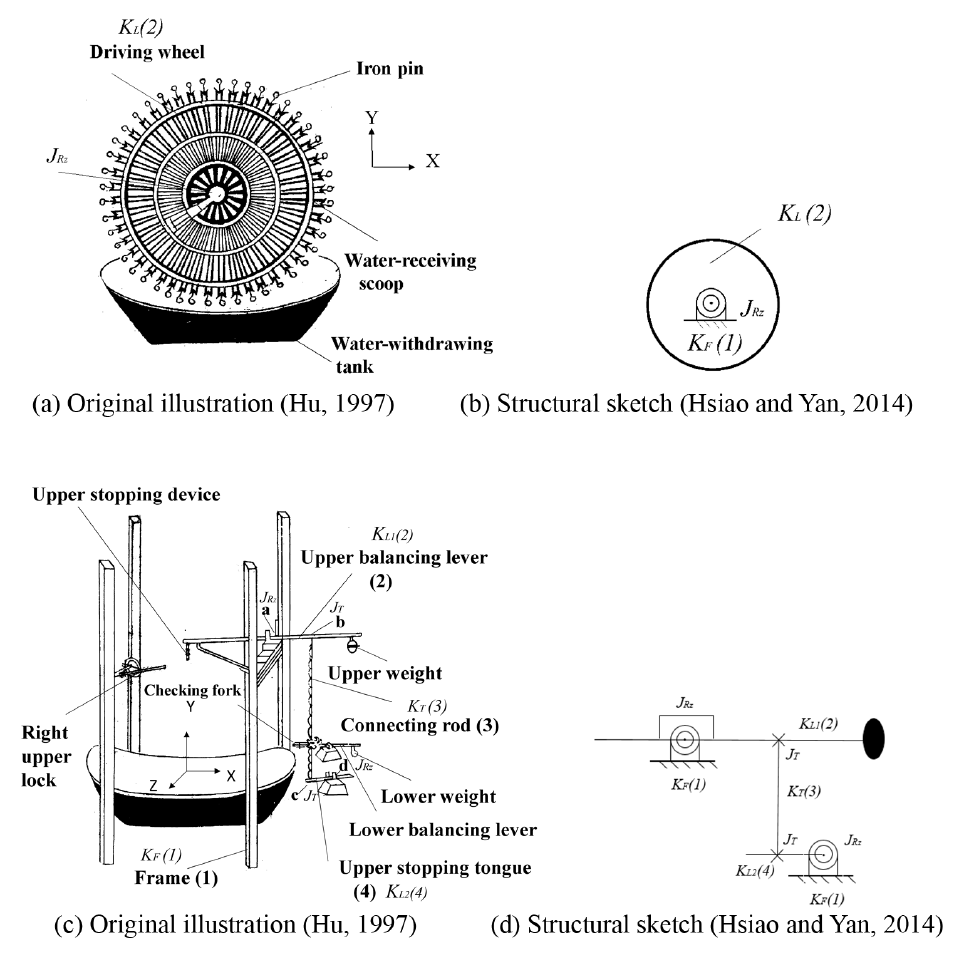
Figure 8. Su Song’s driving wheel and upper balancing lever mechanism.